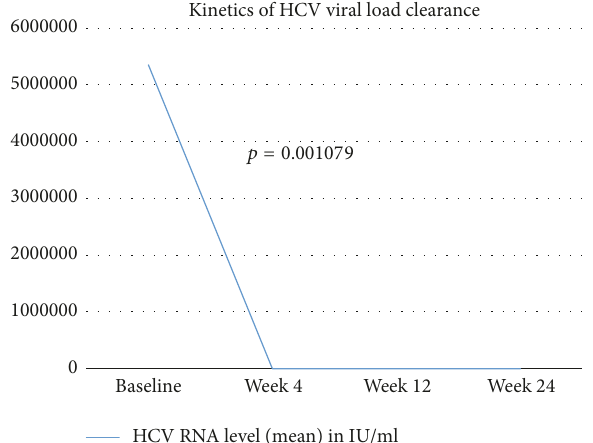
Figure 2: Kinetics of HCV viral load clearance. The decrease in mean HCV RNA level from baseline at start of therapy to that at week 4 was statistically significant (two-sample 𝑡 -test; 𝑝 = 0.001079 ).